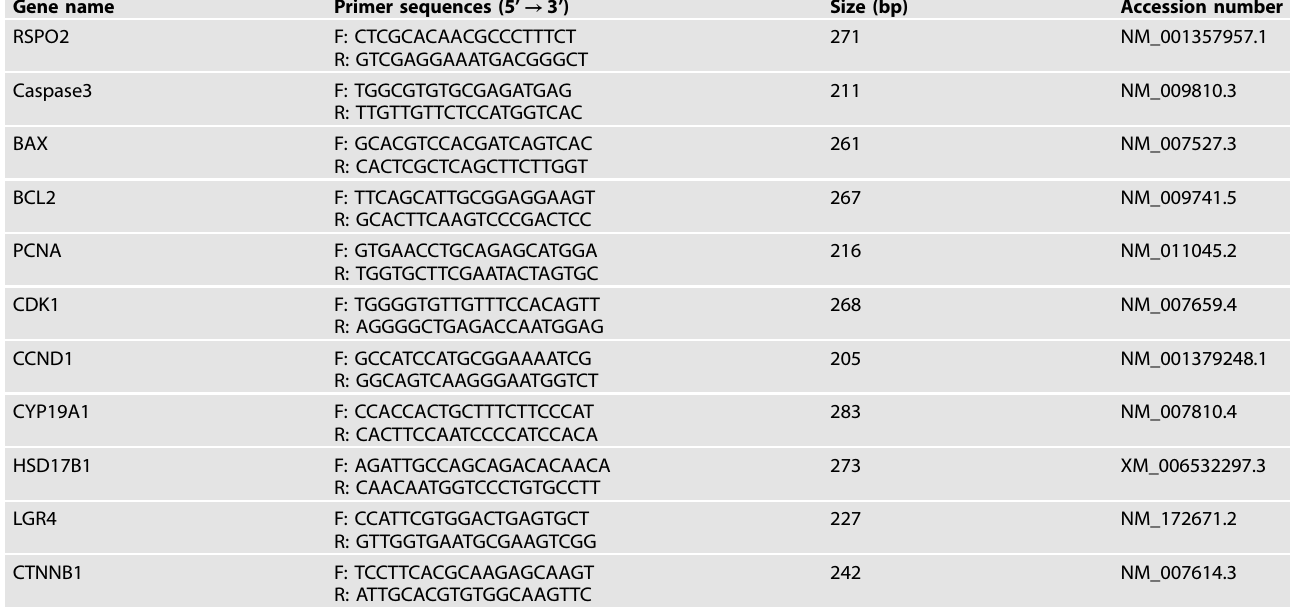
Table 2. Primers used for qRT-PCR in